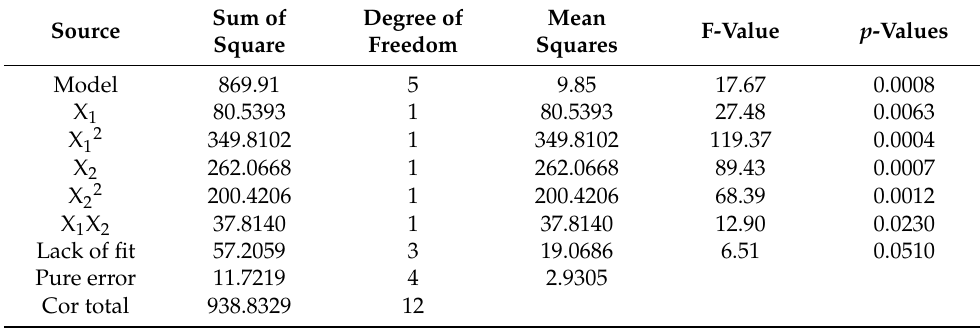
Table 10. Variance analysis of regression equation Y